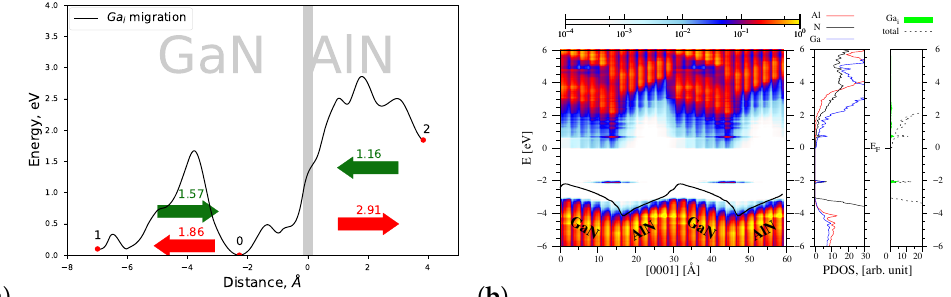
Figure 9. ( a ) Joint profile of the migration energy barrier of gallium interstitial Ga i at the AlN/GaN strained interface type, ( b ) the density of states projected on the atom quantum states (PDOS), showing the spatial variation of the valence and conduction bands in the GaN/AlN heterostructure, as well as the total DOS and PDOS functions associated with Al, N, and Ga atoms, denoted by red, black and blue lines, respectively. The green shade represents PDOS resulting from Ga i